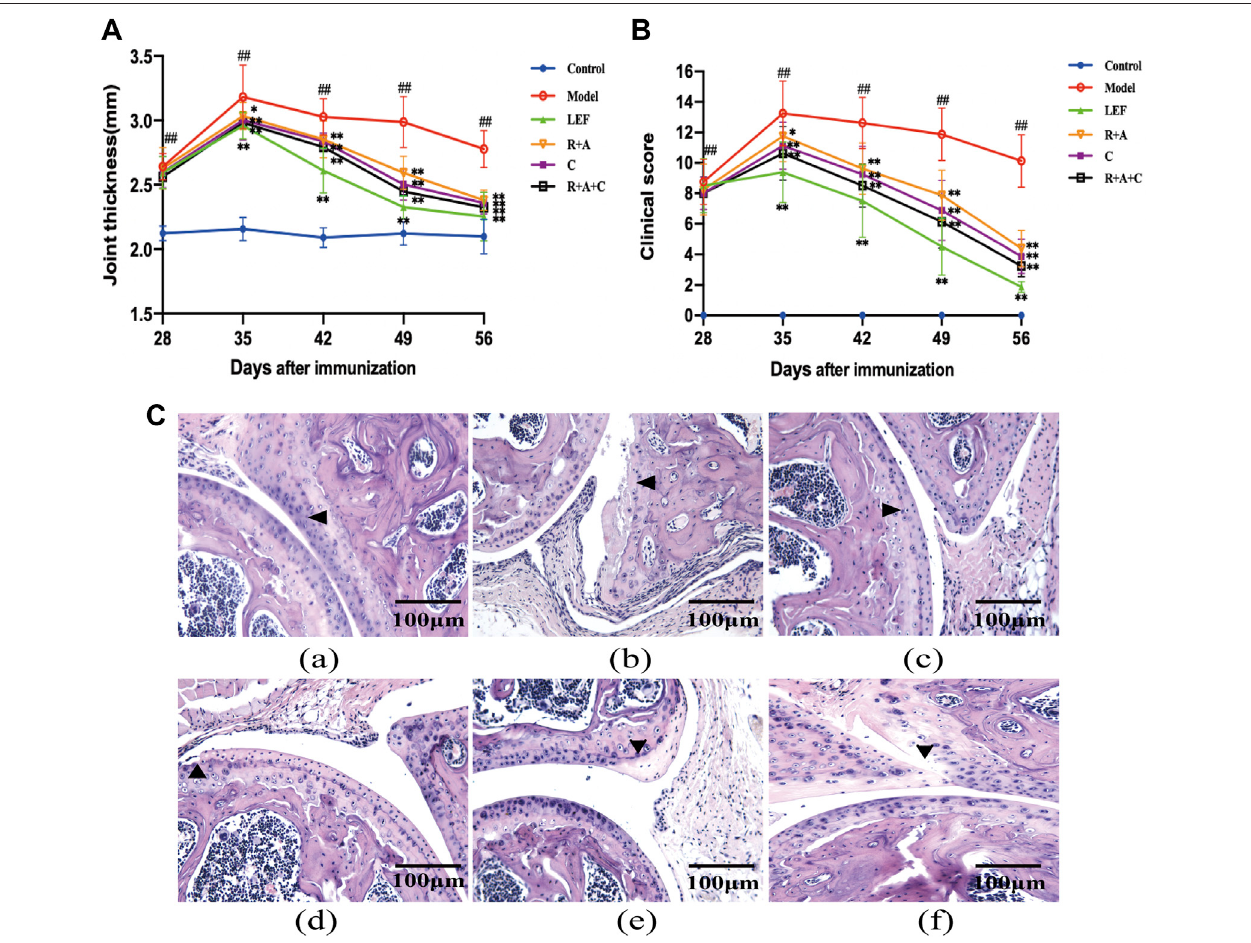
FIGURE 2 | The combination of three herbs reduced the severity of joint swelling in CIA mice. (A) Joint thickness of control and CIA mice. (B) Clinical scores of control and CIA mice. (C) Hematoxylin-eosin (HE) staining of synovial tissue of joint (magni fi cation ×200). The triangle indicates articular cartilage. (a) , control group; (b) , modelgroup; (c) ,LEFgroup; (d) , R . astragali + R . angelicaesinensis (R+A)group; (e) , C . lonicerae (C)group;and (f) , R . astragali + R . angelicaesinensis + C . lonicerae (R + A + C) group. All data are shown as mean ± SD ( n = 8); # p < 0.05, ## p < 0.01, compared with the normal group; * p < 0.05, ** p < 0.01, compared with the model